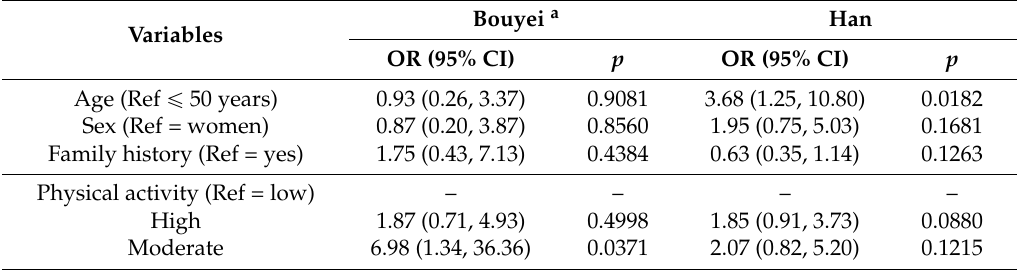
Table 4. Results of Multilevel Logistic Models for Hypertension Control in Treated Bouyei and